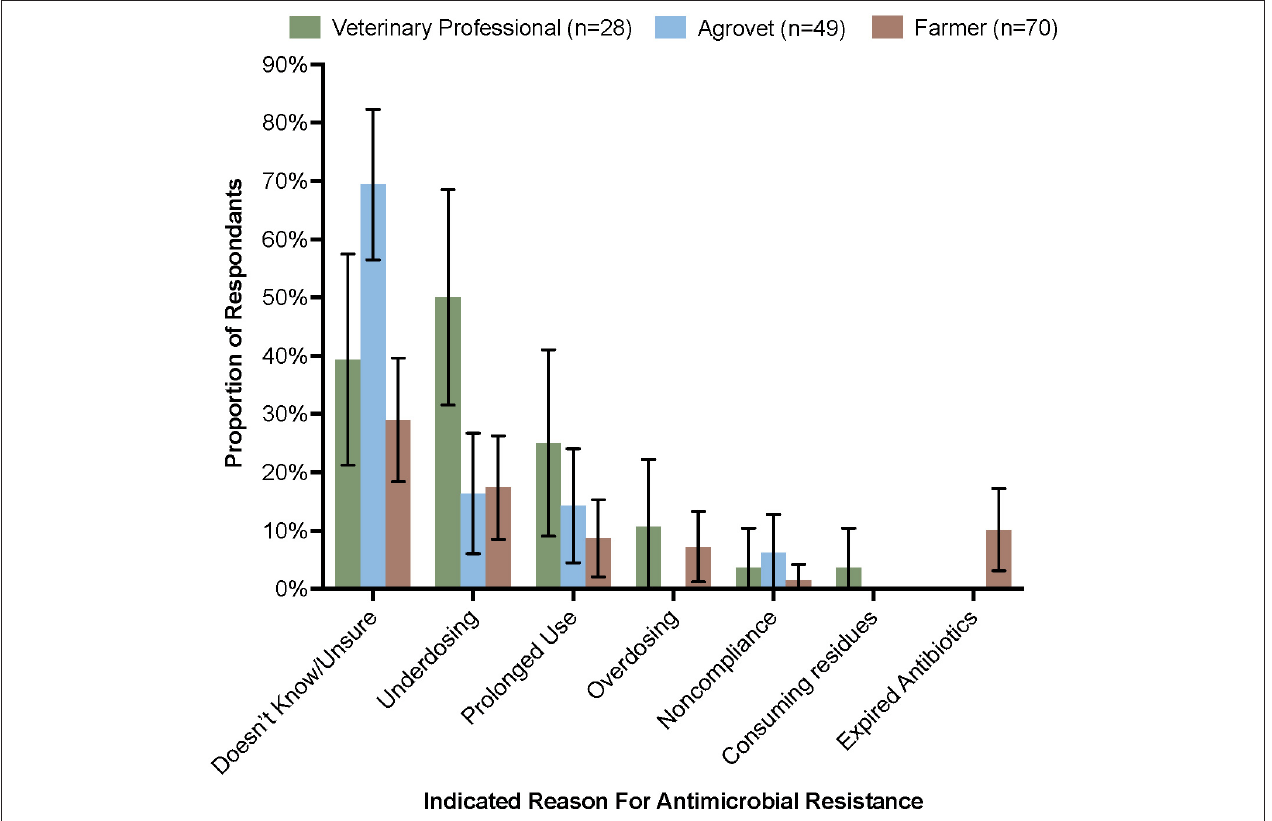
FIGURE 4 | Most common responses given by participants indicating what they thought were the main causes of antimicrobial resistance. Error bars are 95%